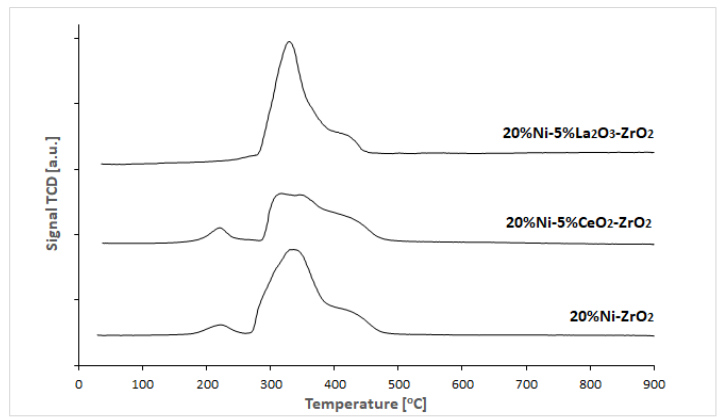
Figure13. Temperatureprogrammedreductionprofilesof20%Nicatalystssupportedon5%La 2 O 3 -ZrO 2 , 5%CeO 2 -ZrO 2 , and ZrO 2 calcined in an air atmosphere for 4h at 400 ◦ C.